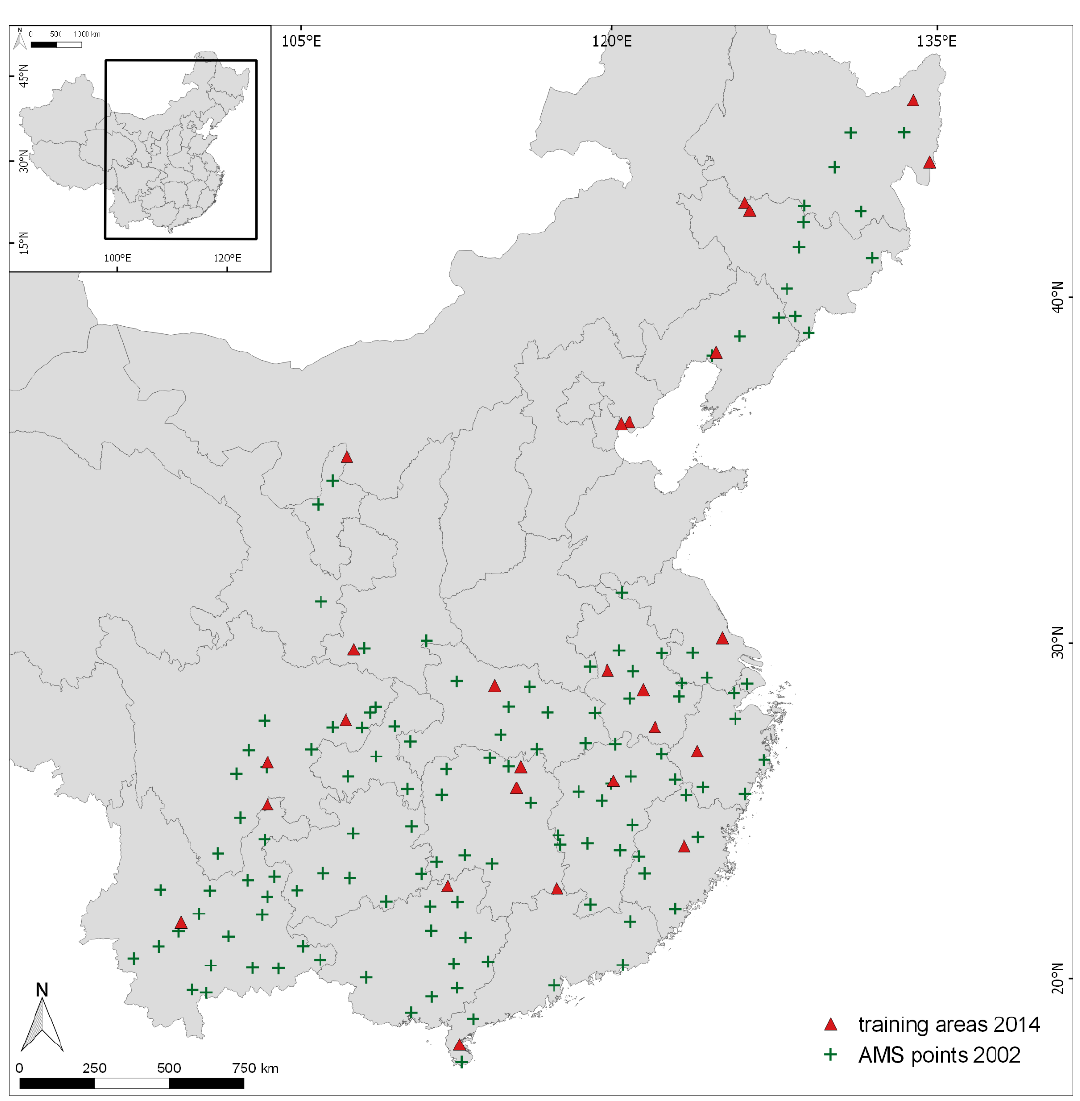
Figure 2. Distribution of reference data in mainland China’s major rice growing regions.